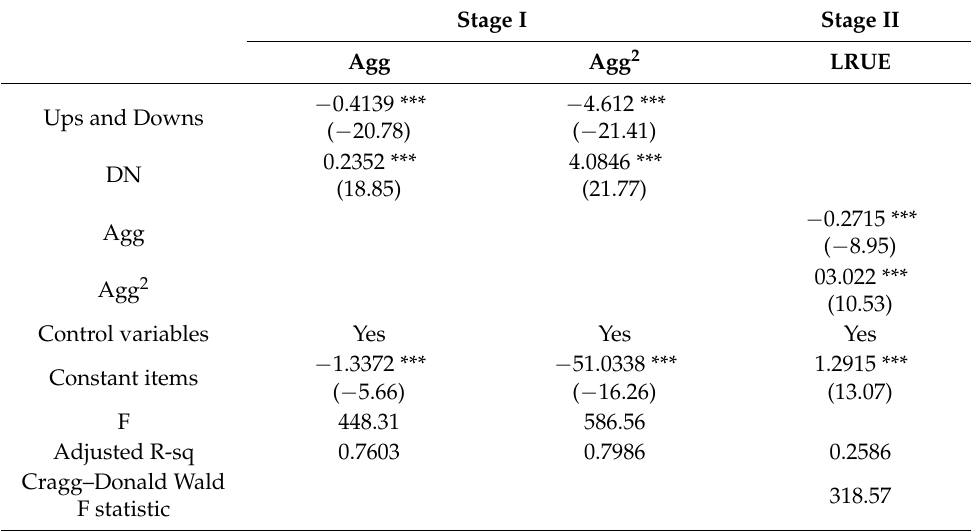
Table 7. Regression results of the spatial econometric model.